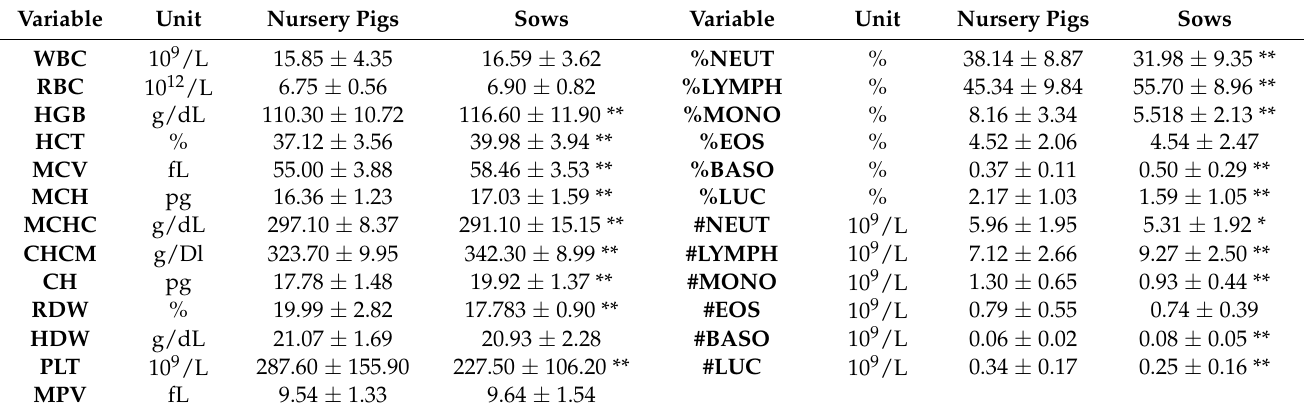
Table 1. Comparison of hematologic parameters between nursery pigs and sows.